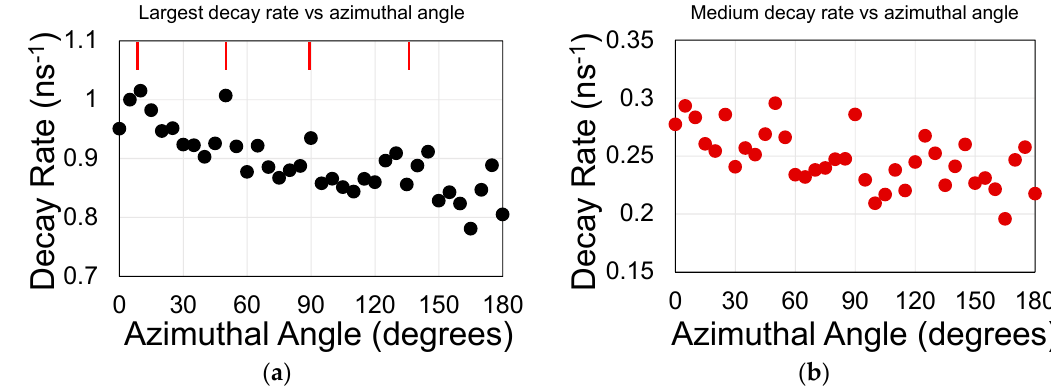
Figure 7. Decay rate coefficients in ns − 1 for sample S2 exhibiting 45° symmetry for both, ( a ) the largest rate and ( b ) the medium rate. The red lines point to the peaks.